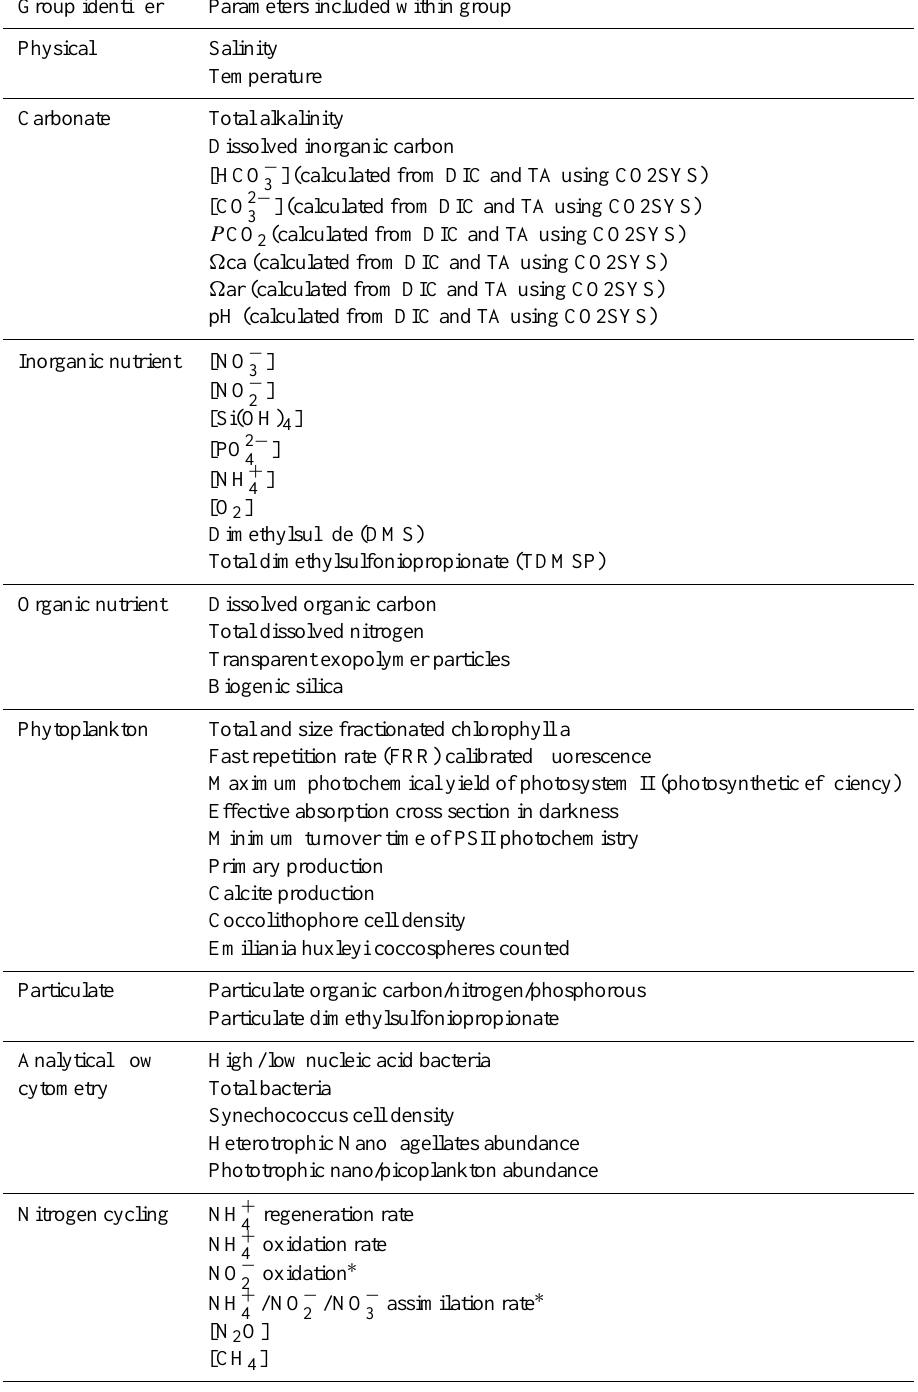
Table 2. Identification of parameters arranged within groups for statistical analysis of bioassay and observational